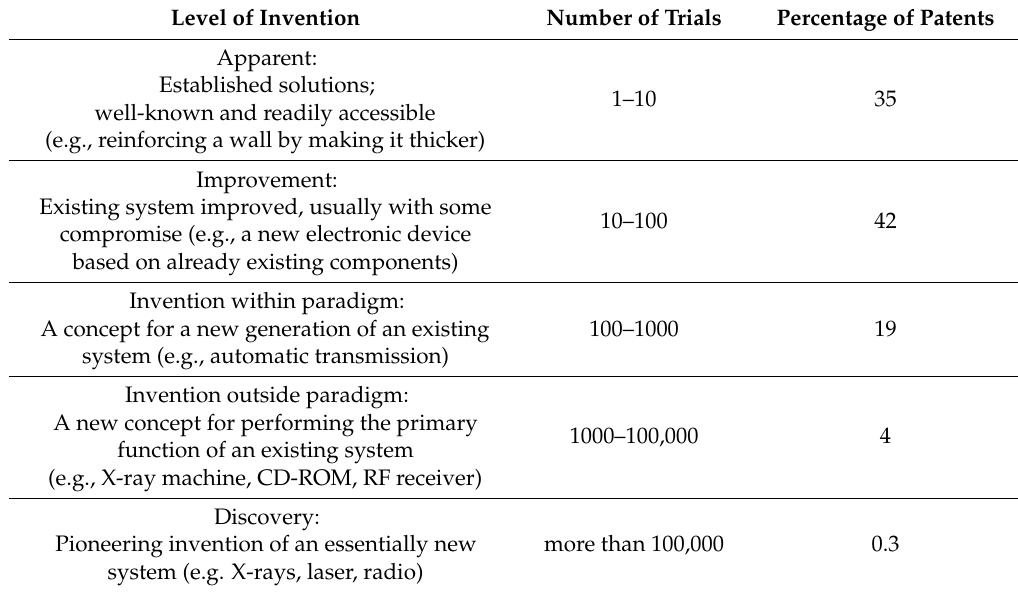
Table 1. Level of invention and number of